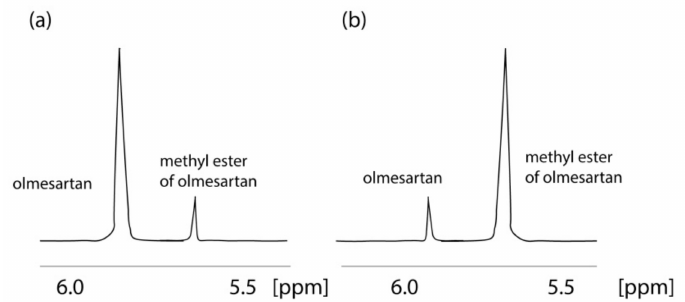
Figure 3. Formation of methyl ether of olmesartan with time. 1 H NMR spectra of 2 mg of olmesartan dissolved in CD 3 OD obtained on a Bruker Avance III spectrometer (Bruker Biospin GmbH, Reinsteten, Germany) operating at 600.11 MHz for 1 H at 45 ◦ C: ( a ) recorded 4 h after dissolution; ( b ) recorded after 52